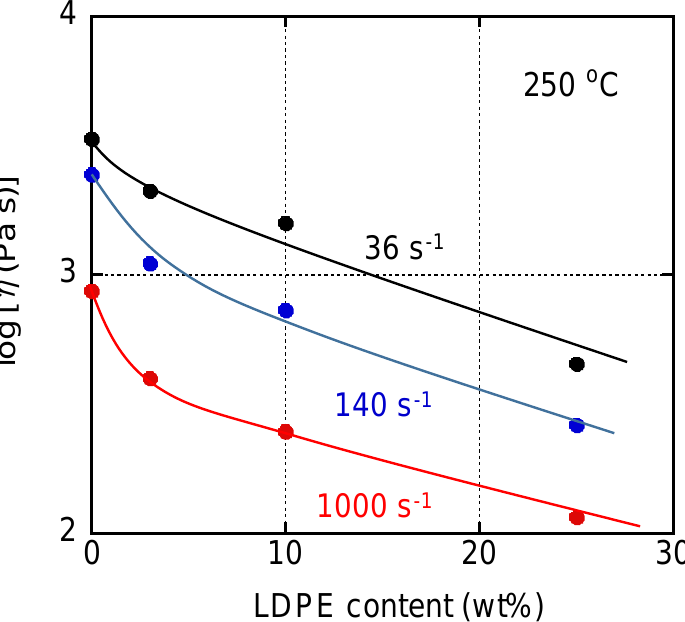
Figure 6. Steady-state shear viscosity η plotted against the LDPE content at various shear rates at 250 °C. The measurements were carried out using a circular die with L/D = 10/1.